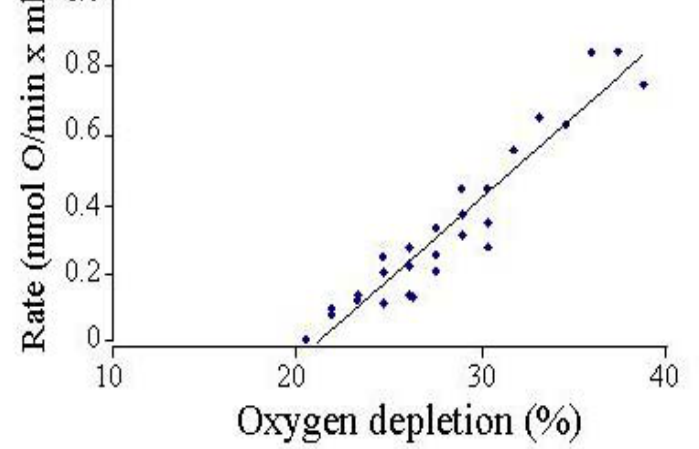
Figure 3. Oxygen back-diffusion rate in 2-well chambers. The cell-free chamber was assembled with buffer (150mM NaCl, 20mM TES pH 7.2, 0.3% albumin) partially depleted of oxygen with nitrogen. The oxygen tension was measured over 2-3